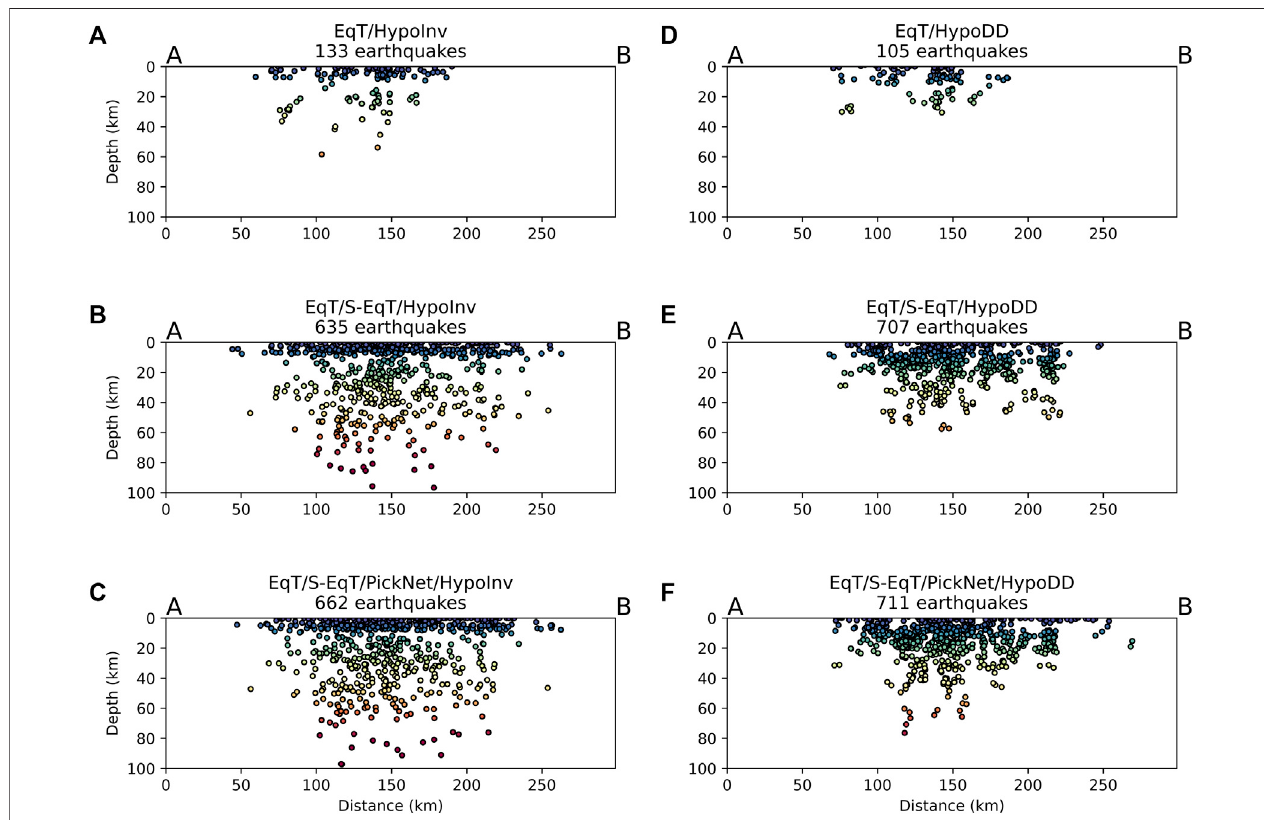
FIGURE 4 | Comparison of location results in the sections which are identi fi ed in Panel 3 . The three pictures from top to bottom on the left, (A – C) correspond to Panels 3A – C , respectively. The three fi gures on the right (D – F) correspond to Panels 3D – F .